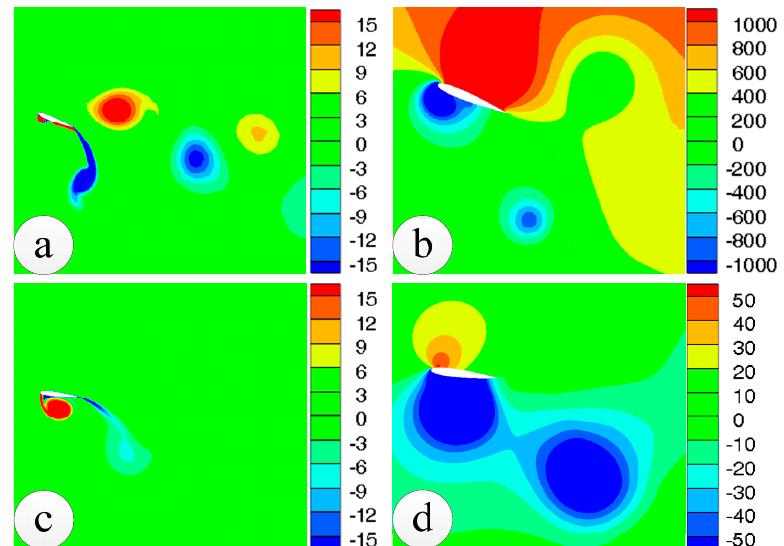
Figure 10. Comparison of ( a ) the instantaneous vorticity contours for f ∗ = 0.68 at t / T = 0.1, ( b ) the corresponding pressure contour for f ∗ = 0.68 at t / T = 0.1, ( c ) the instantaneous vorticity contour for f ∗ = 0.17 at t / T = 0, and ( d ) the corresponding pressure contour for f ∗ = 0.17 at t / T = 0.